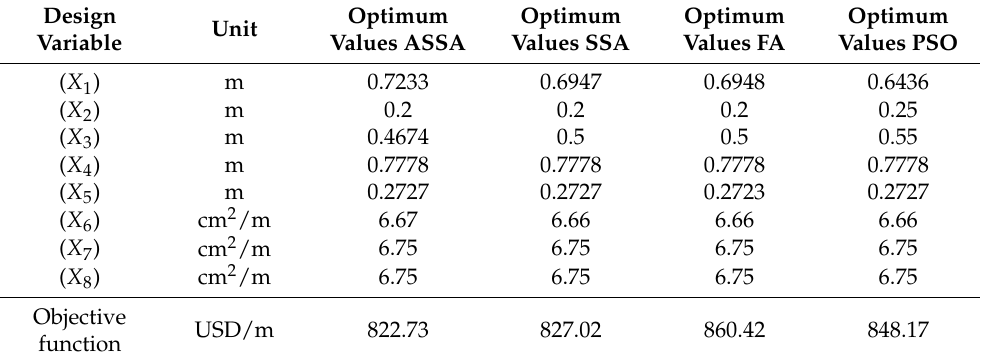
Table 18. Optimization results for design example 3.